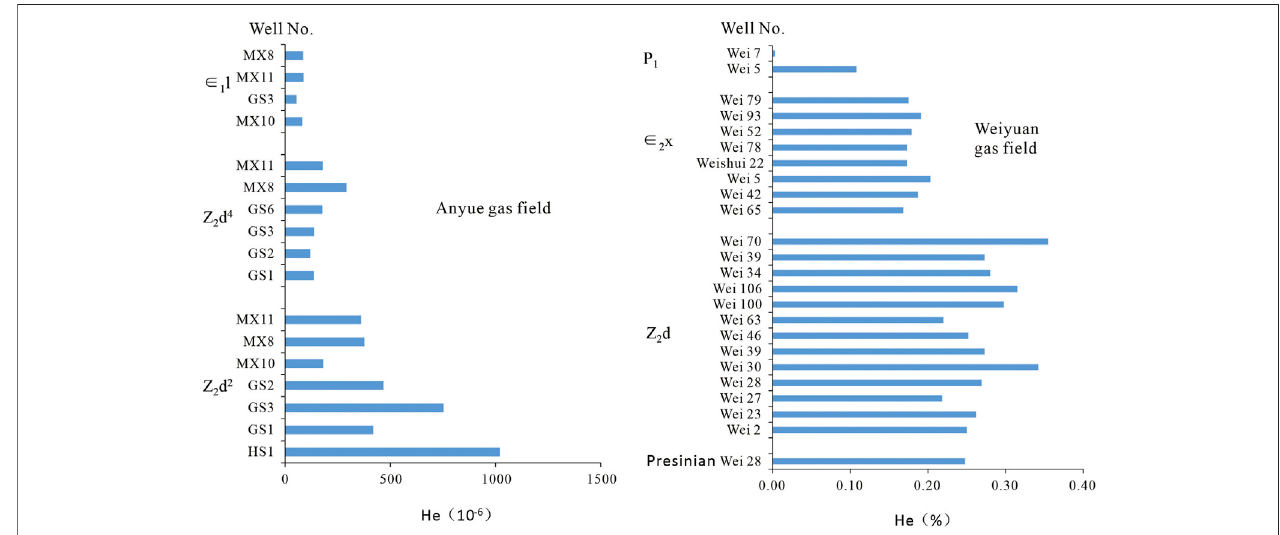
FIGURE 7 | Helium contents in natural gases in different layers in the Anyue and Weiyuan gas fi elds (Data sited from Zhu et al., 2007; Wei et al., 2014; Zheng et al., 2014; Zhang et al., 2015).